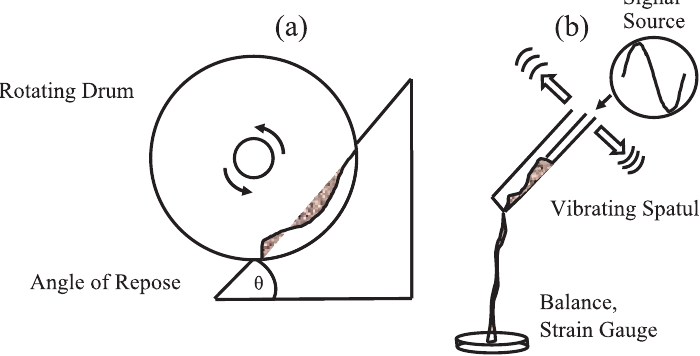
Fig. 7 Diagrams of (a) the rotating drum dynamic angle of repose measurement technique and (b) vibrating spatula with mass